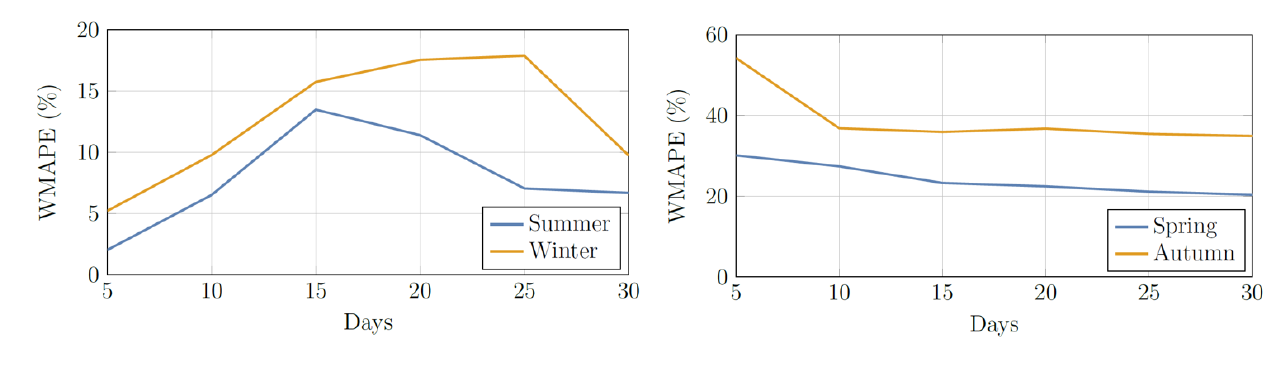
Figure 13. Mean Absolute Percentage Error referred to summer and winter days for different sizes of the training set (from 5 to 30 days), (on the left ). WMAPE referred to spring and autumn days for different sizes of the training set (from 5 to 30 days), (on the right